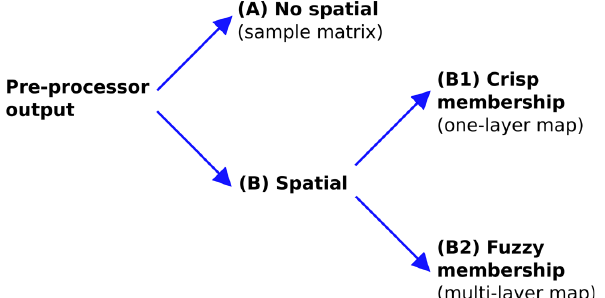
Fig. 5. Scheme of pre-processor output options, (A) no spatial, sam- ple matrix of sample weights and environmental characteristics; (B1) spatial with crisp membership, single layer maps; and, (B2) spatial with fuzzy membership, multi-layer maps with a number of chosen fuzzy membership dimensions.